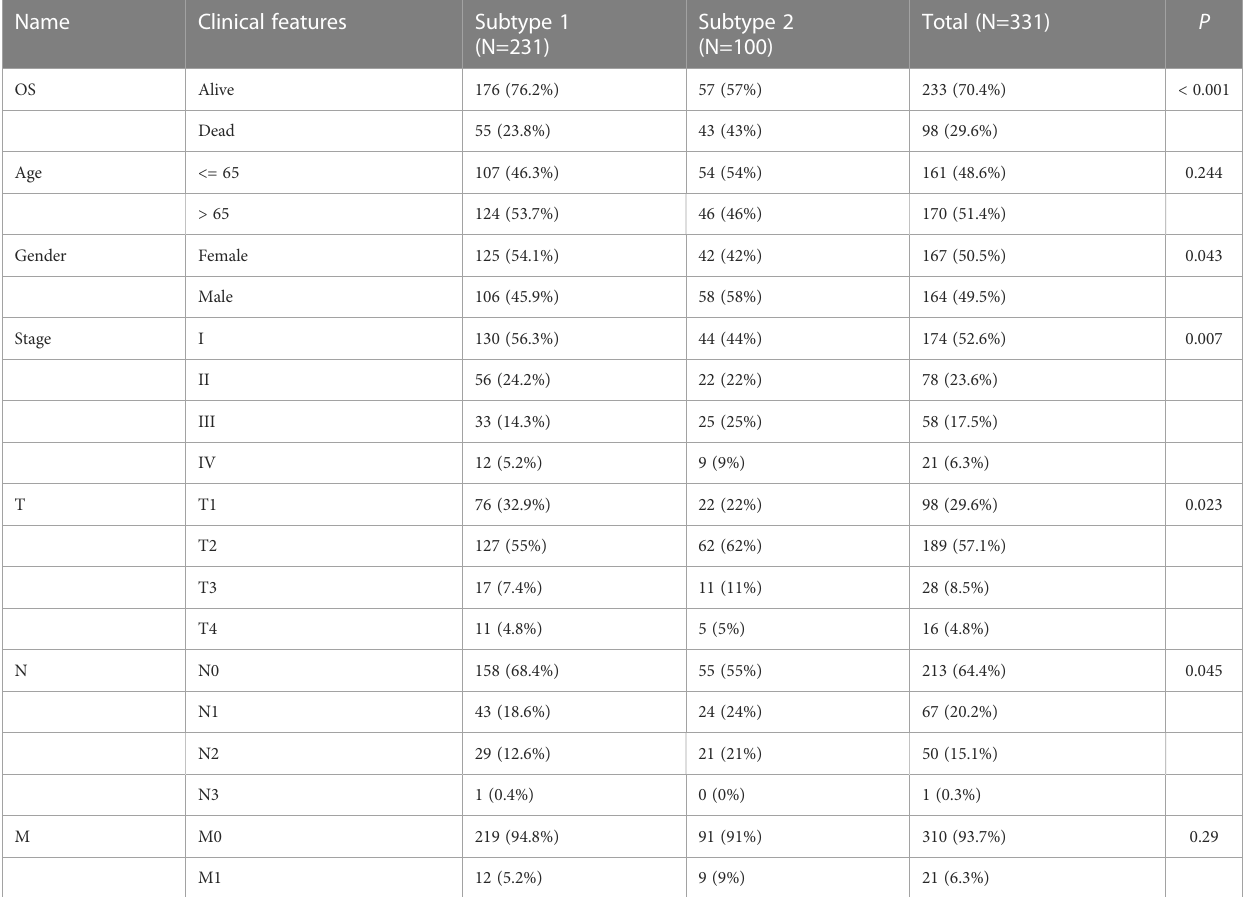
TABLE 1 Clinical features of patients in subtypes 1 and